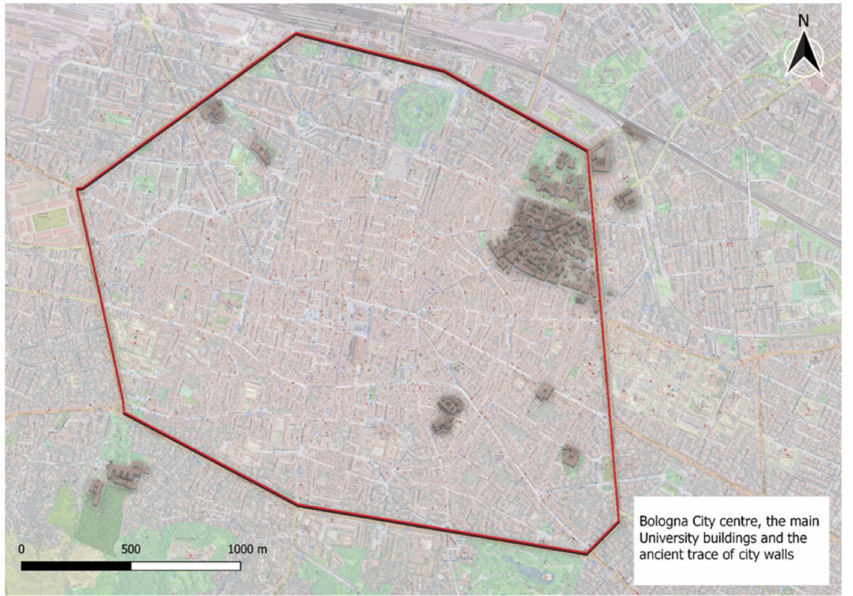
Figure 1. Bologna City center, the main university buildings located in the central area and the ancient trace of city